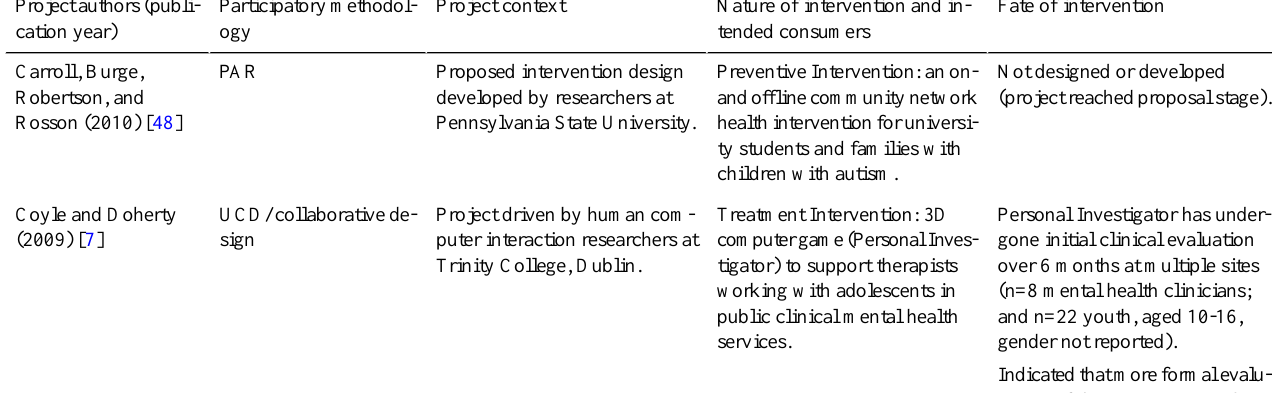
Fate of interventionNature of intervention and